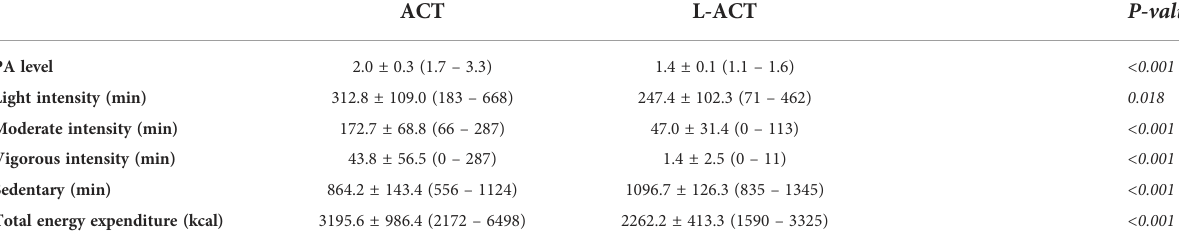
TABLE 2 The title needs to be updated to: Comparison of accelerometry data between ACT and L-ACT.